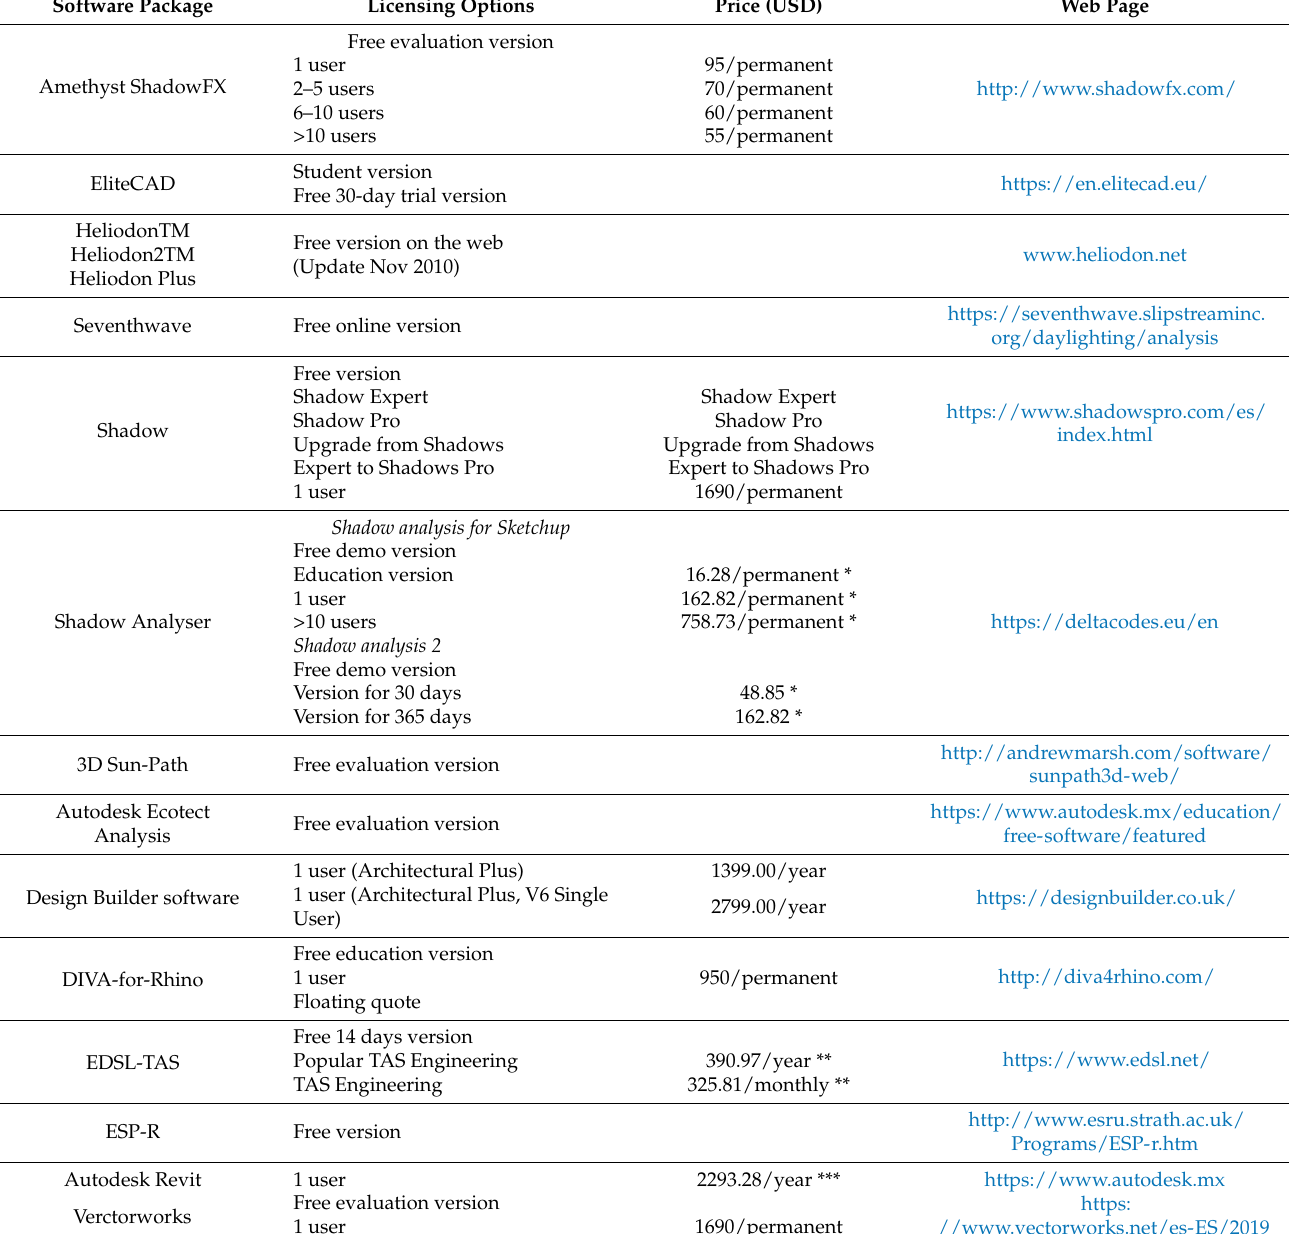
Table 3. Licensing option of the software